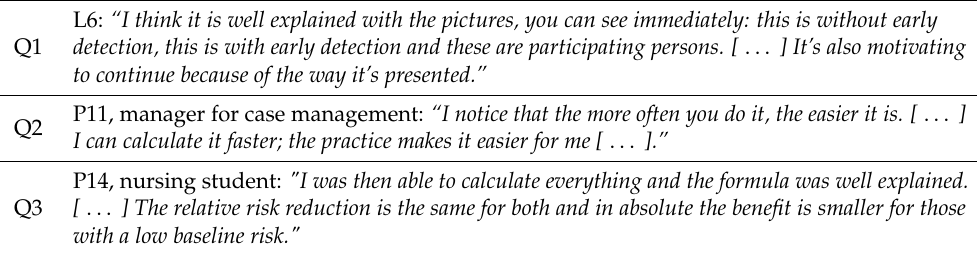
Table 3. Quotes for improvements following the revision.